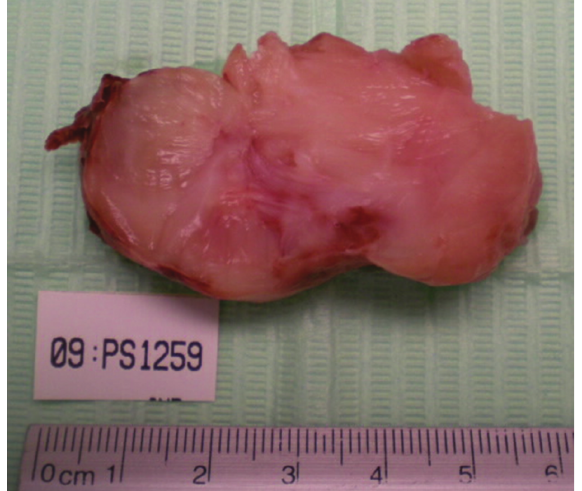
Figure 3: The cut section of excised tumor